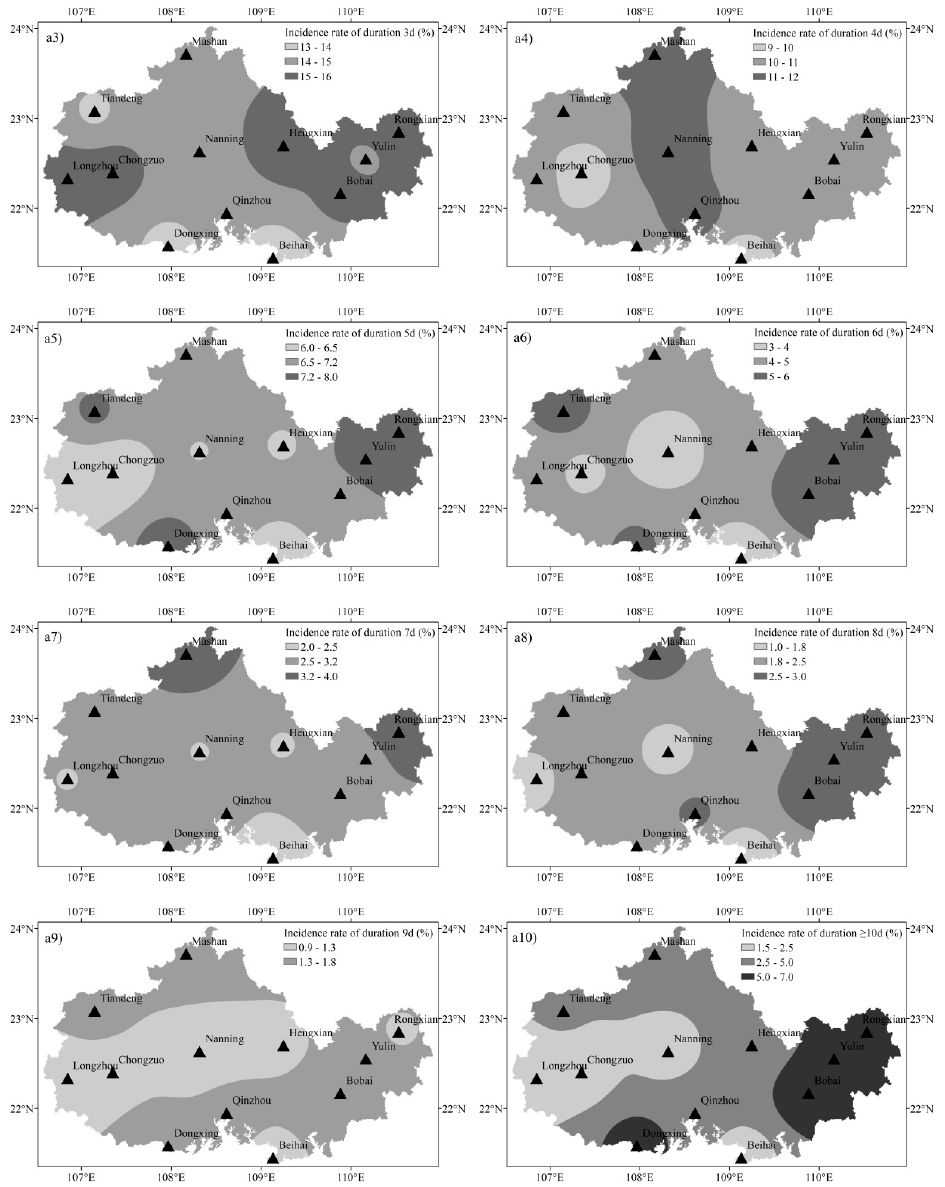
Figure A1. Spatial distribution of incidence rate of di ff erent precipitation durations in rainy season in the Beibu Gulf.